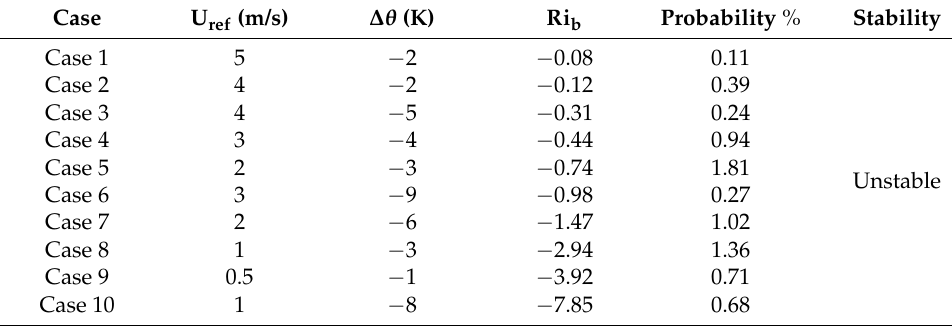
Figure 7. Multivariate distribution of U ref and ∆ θ . Table 4. Bulk Richardson number